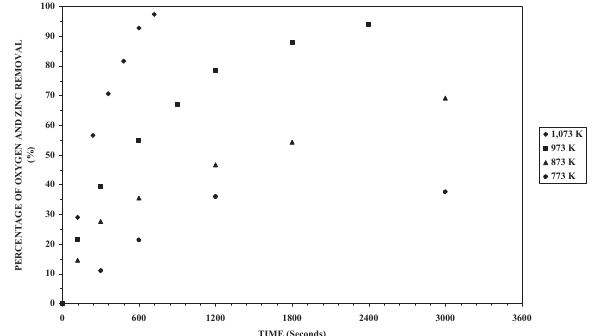
Figure 4. Effect of temperature on the reduction of zinc ferrite in 1 l = 60 seconds of